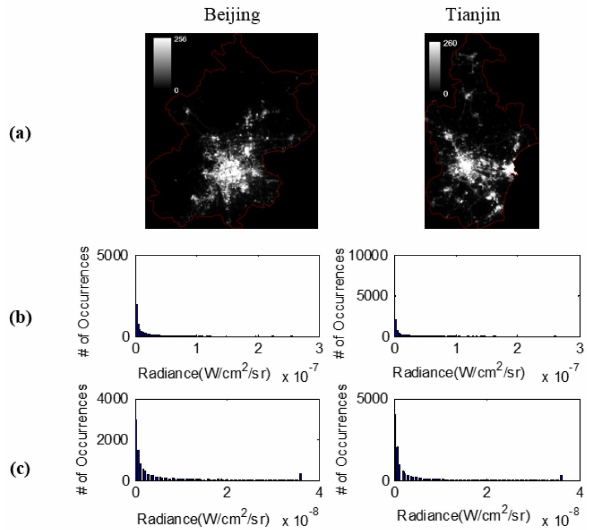
Figure 8. ( a ) DNB imagery derived with NMM for Beijing (left) and Tianjin (right); ( b ) histograms of DNB NMM data; ( c ) histograms of DNB NMM data transformed with finite quantization for Beijing (left) and Tianjin (right),